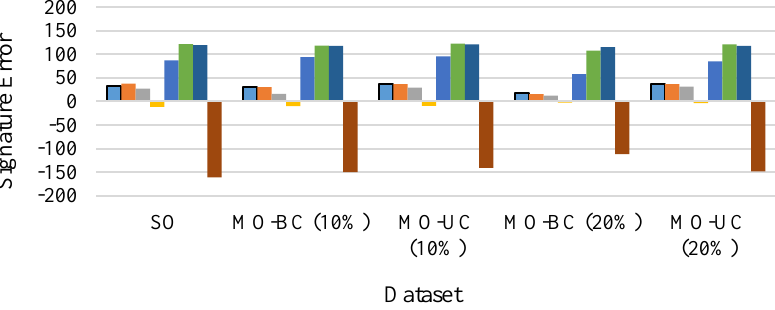
Figure 14. E QP errors based on observations and simulations of five datasets using two main calibration approaches (SO & 4 algorithms parameterization of MO-SB).